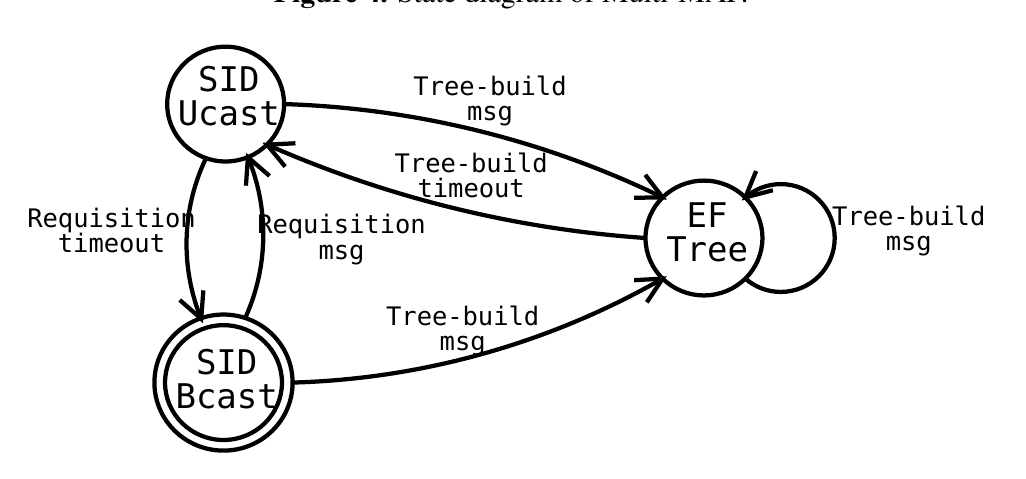
Figure 4. State diagram of